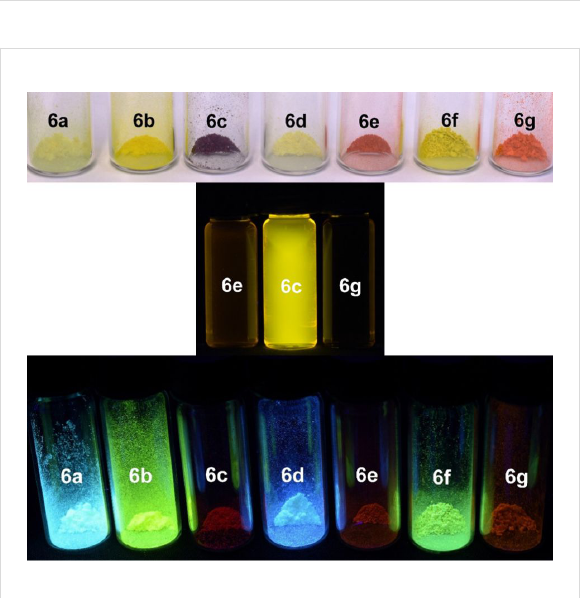
Figure 8: α -Pyrones 6 as solids under daylight (top), selected deriva- tives under UV light ( λ exc = 365 nm, c ( 6 ) = 10 − 4 M) in dichloromethane solution (center), and under UV light ( λ exc = 365 nm) in the solid state